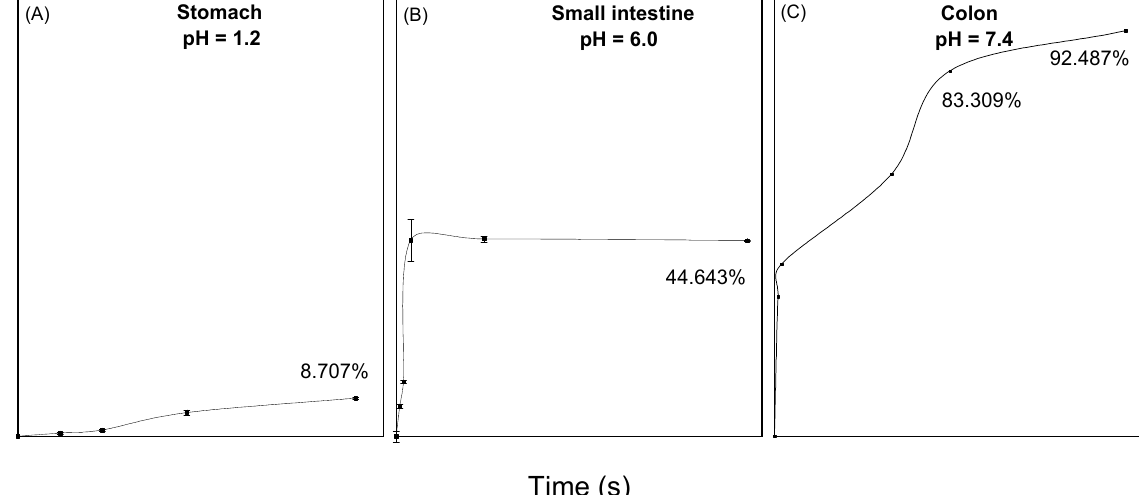
Figure 2. Release curves of genistein encapsulated in BNC at different pH and at 37 °C. ( A ) Simulated stomach fluid at pH 1.2; ( B ) simulated small intestine fluid at pH 6, and ( C ) simulated colon fluid at pH 7.4.